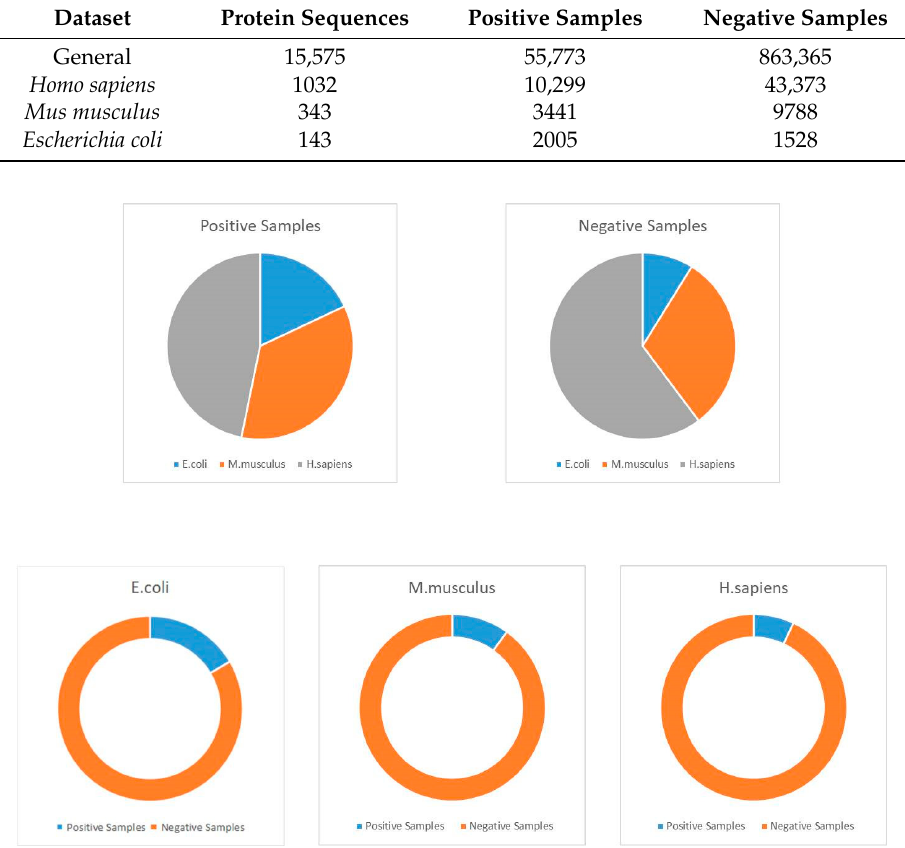
Figure 4. Distribution of employed datasets.